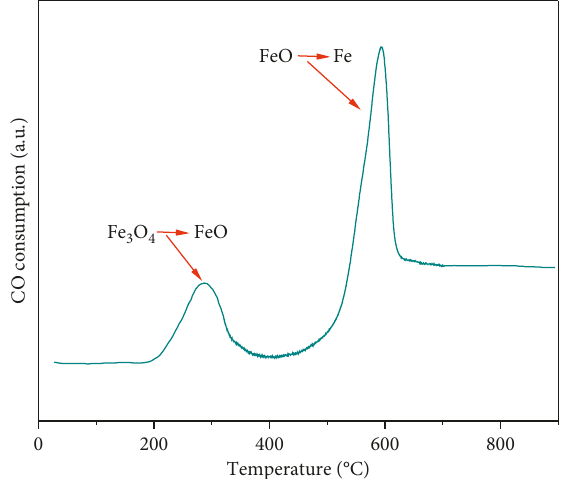
3 O 4 nanoparticles.